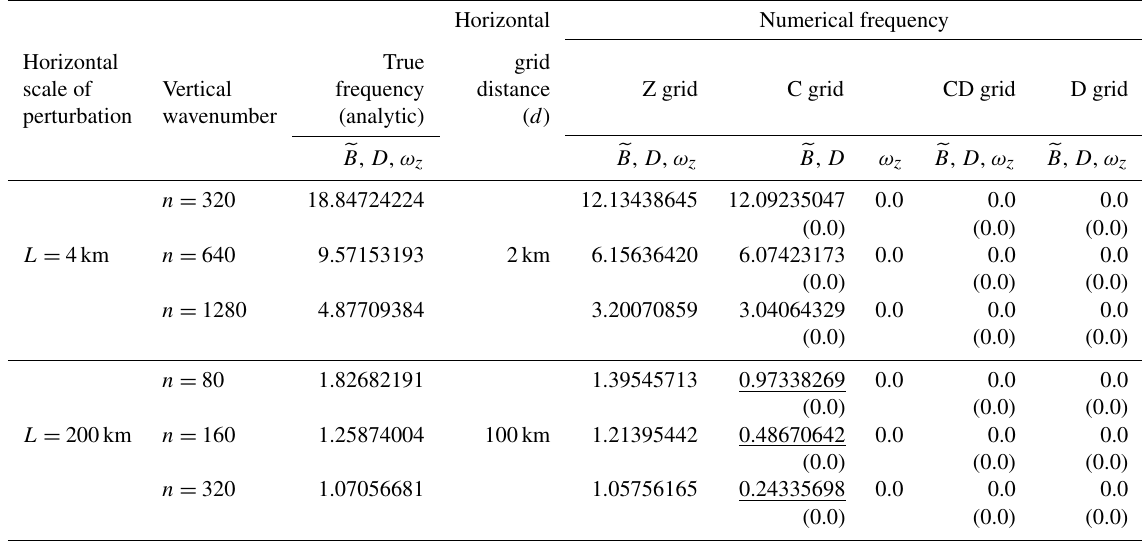
Table 5. Same as Table 4 but using d = L/ 2. Zero frequencies indicate dynamically inert computational modes. Zeros within parentheses indicate the frequency of the buoyancy and divergence if the initial perturbation is only given to the vorticity. Horizontal Numerical frequency Horizontal True grid scale of Vertical frequency distance